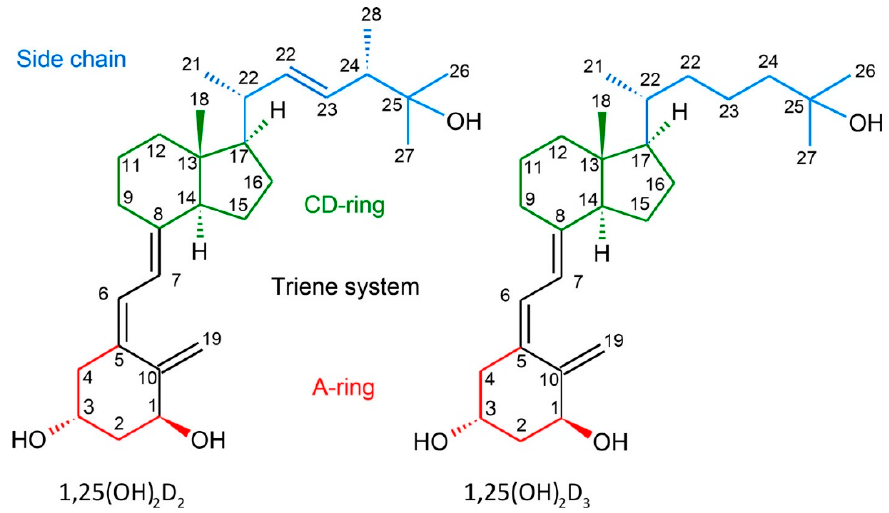
Figure 1 . Numbering system and structural parts of 1,25(OH) 2 D 2 and 1,25(OH) 2 D 3 . Reprinted with permission from Wanat et al. [10] Copyright © 2018 American Chemical Society.